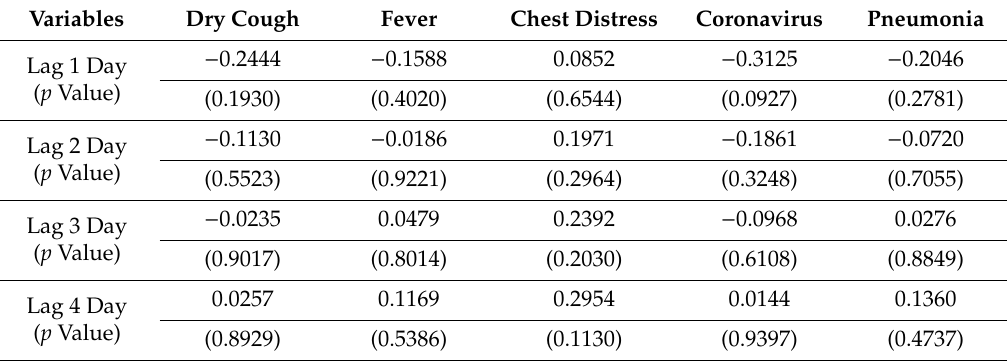
Table 3. Correlation between new confirmed cases number and lag time series of five Baidu